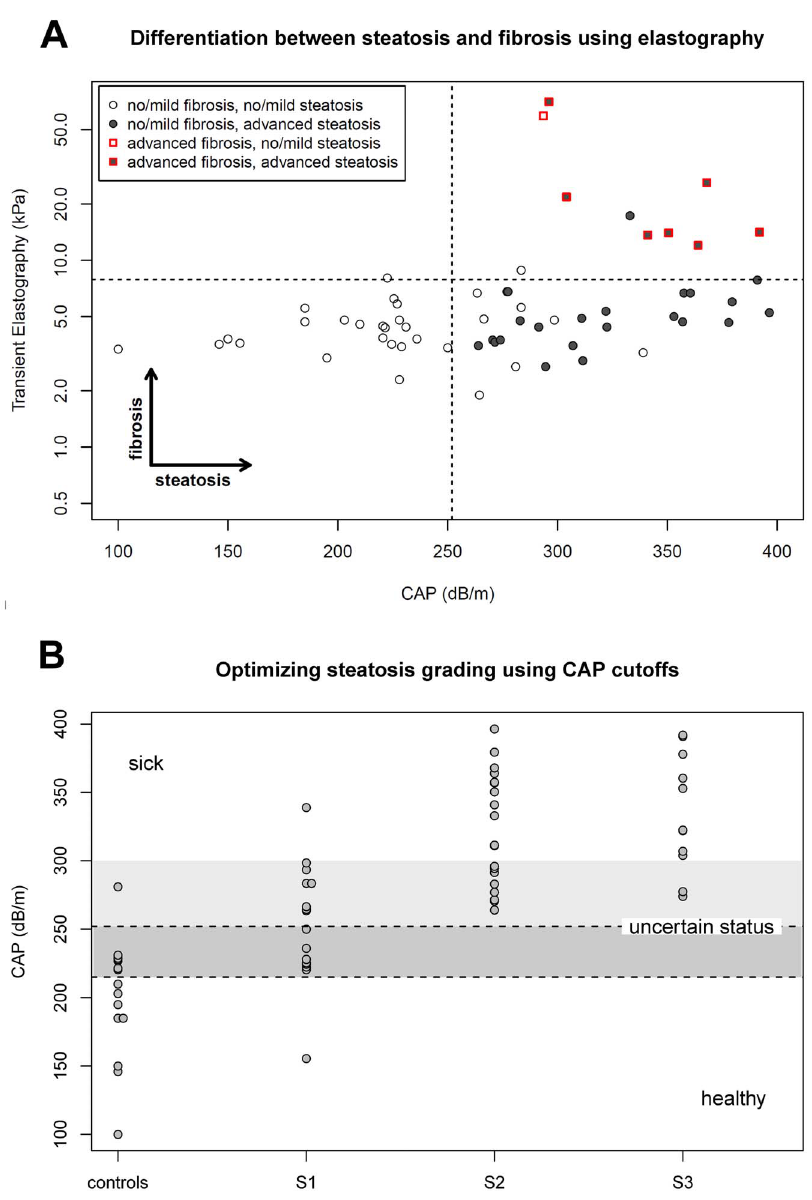
Figure 3. CAP and TE cut-off values for clinical use. Application of published cut-off values for TE (7.9 kPa) and CAP (252 dB/m 2 ) results in high sensitivity for detection of distinct fibrosis and steatosis (A) [19,43]. CAP values between 215 dB/m [19] and 300 dB/m require further diagnostic procedures for differentiation of the degree of steatosis (‘‘grey area’’) (B).